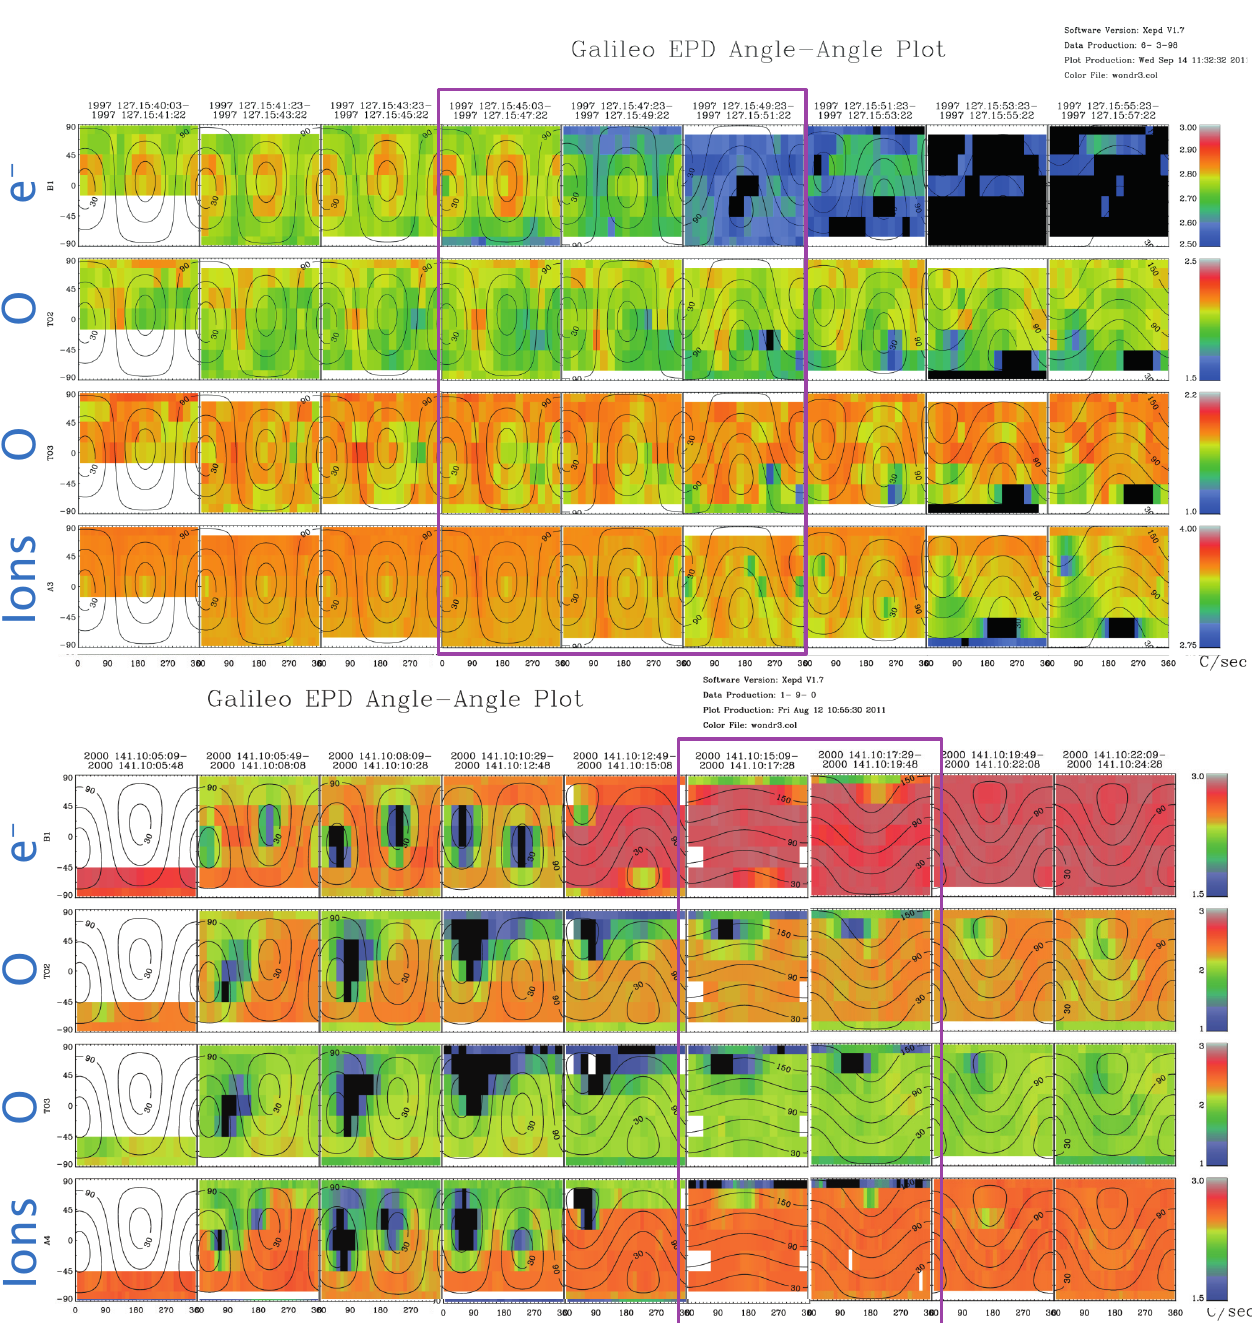
Fig. 11. The EPD energetic particle data for G8 (top) and G28 (bottom). Shown are the electron (B1 1 . 5 ≤ E ≤ 10 . 5MeV), oxygen (T02 416 ≤ E ≤ 816keV, T03 816 ≤ E ≤ 1792keV) and ion data (A1 42 ≤ E ≤ 65keV for protons). The format per small panel is longitude and latitude of the detection sphere with the pitch angle of the particles given as contours and the counts are depicted by the colour bar. The purple boxes indicate the intervals for which ion cyclotron waves are observed in the MAG